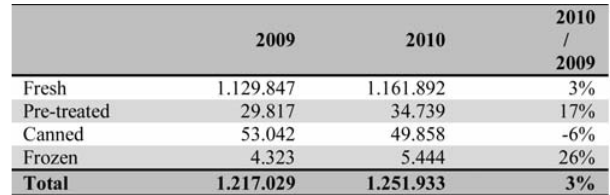
Table 9. Supermarket sales frozen vegetables ( € × 1000)